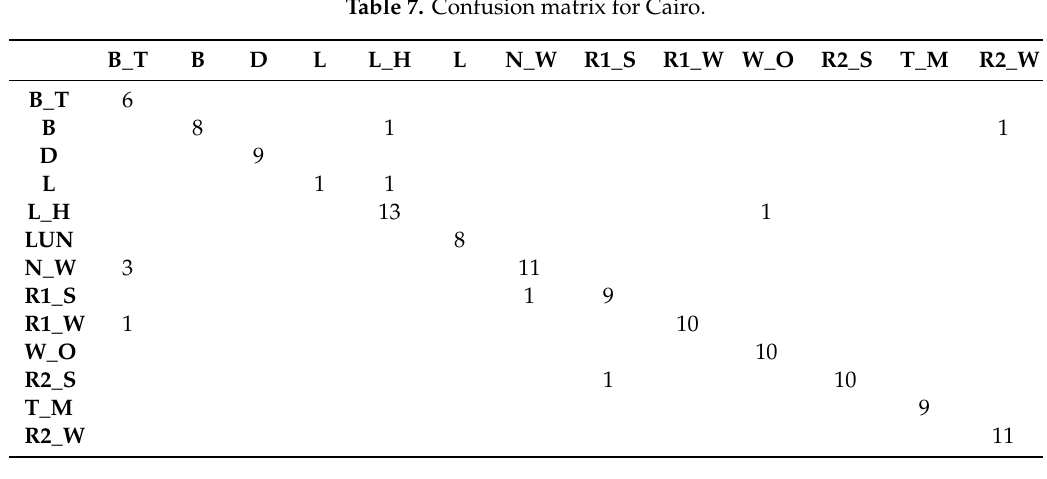
Table 7. Confusion matrix for